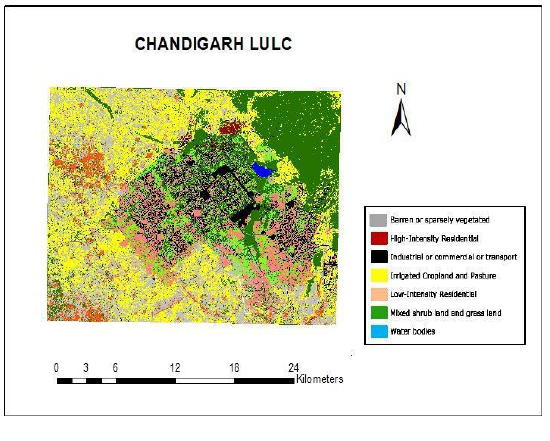
Fig 2: Urban LULC map, Chandigarh